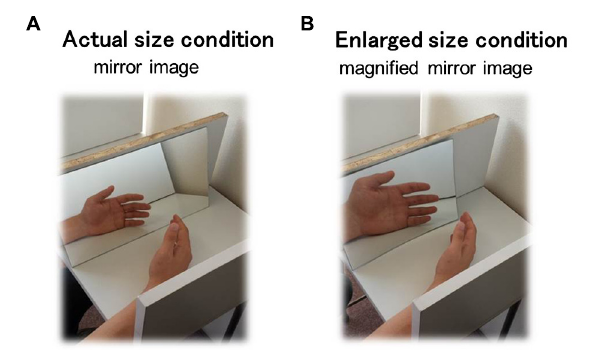
FIGURE 1 | Schema of the experimental paradigm setup in this study. Subjects whose pain threshold and two-point discrimination threshold were measured during visualization of a mirror image of the hand under an actual size condition (A) and an enlarged size condition (B)